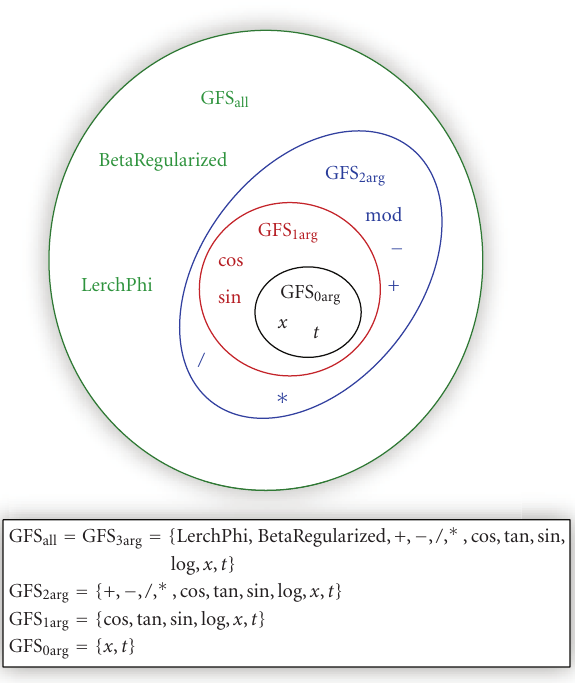
Figure 1: General function set (GFS).